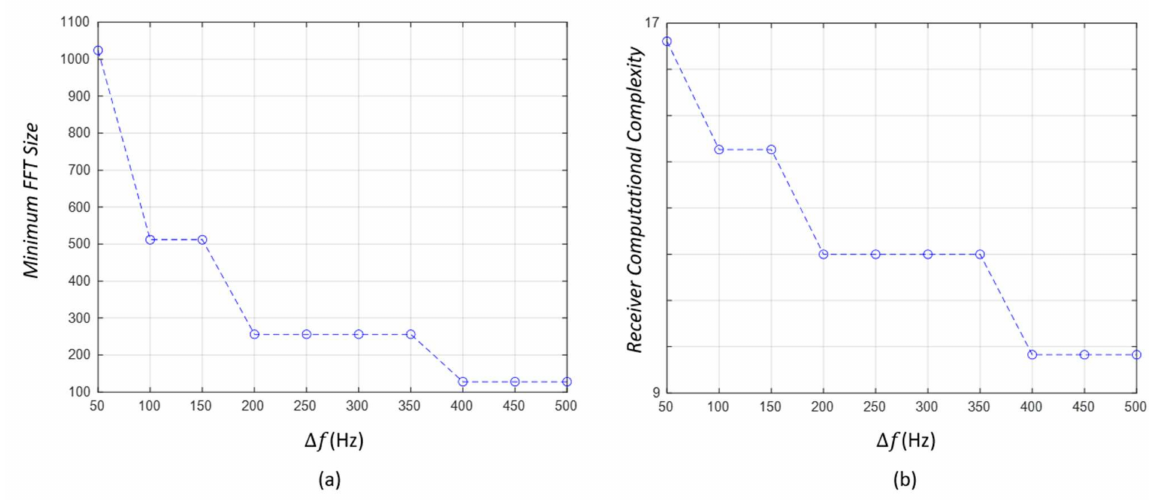
Figure 6. The receiver performance according to ∆ f . ( a ) Minimum FFT size. ( b ) RCC